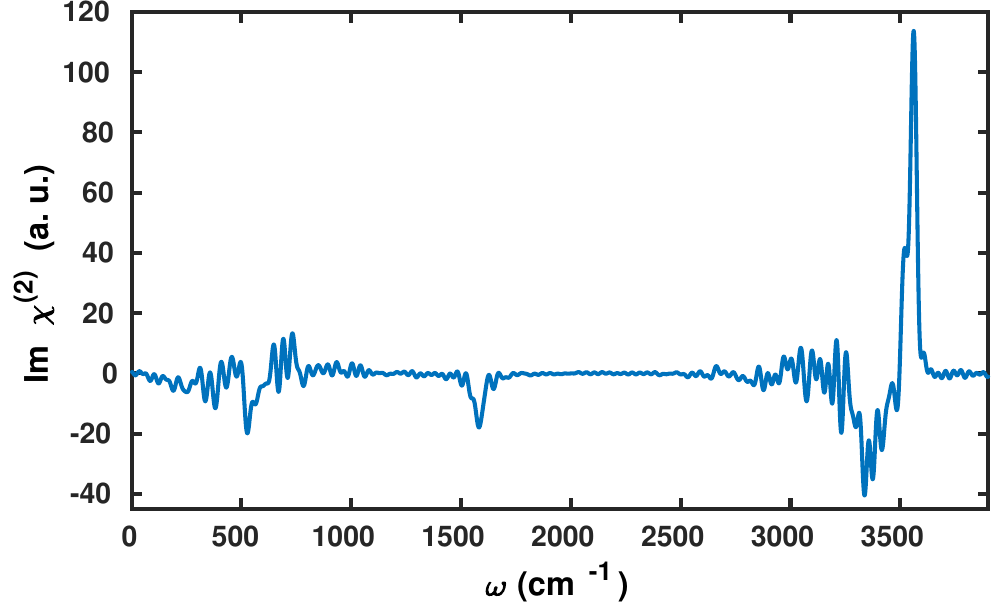
Figure 3. The vibrational sum frequency generation (v-SFG) spectrum of interfacial water molecules computed by the present anisotropic WP